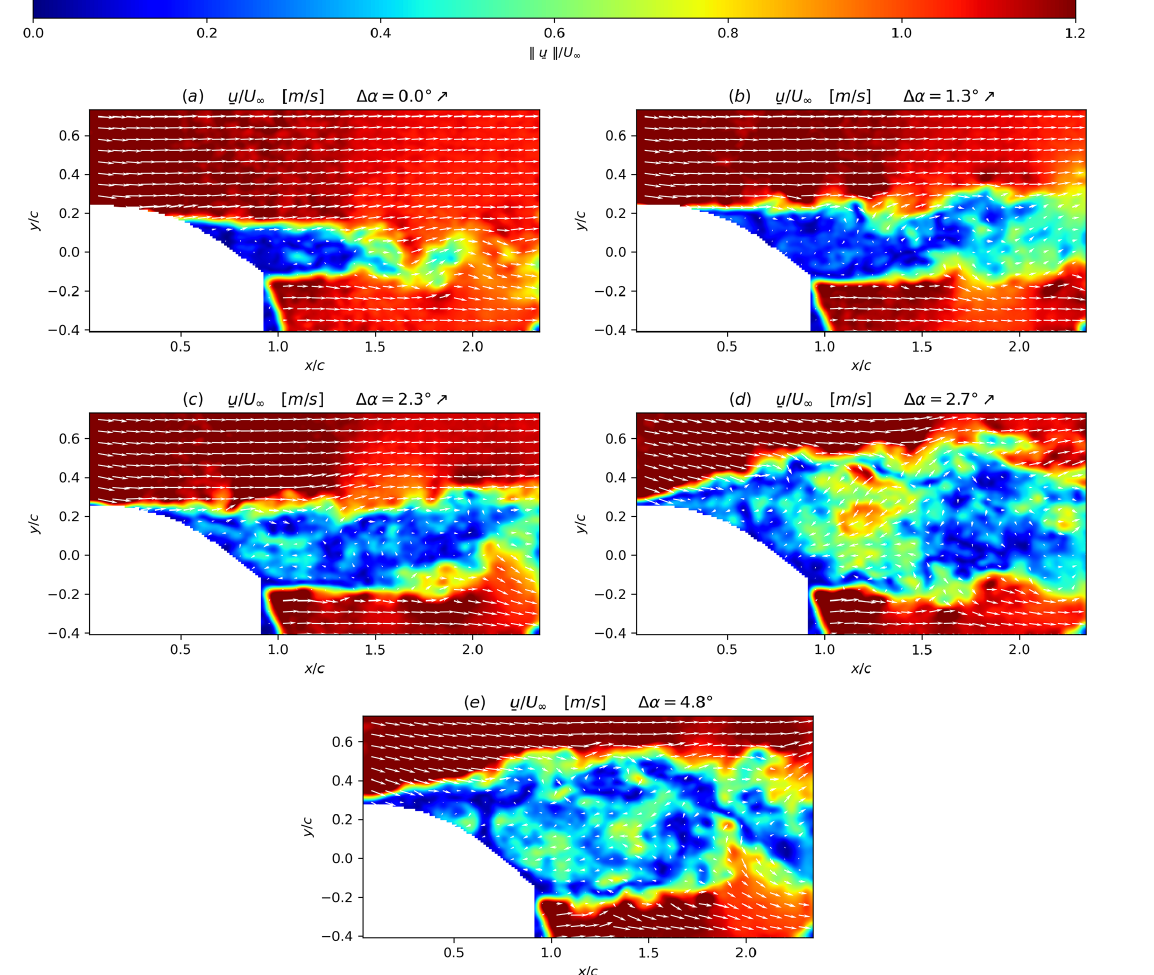
Figure 8. Instantaneous velocity fields superposed with isocontours of the velocity modulus (i.e. (cid:107) u (cid:107) ) at different (cid:49)α values corresponding to points of the blade oscillation given in Fig. 7 during the upstroke phase (noted (cid:37) ): (a) is a point at the lowest (cid:49)α of the upstroke phase of the oscillation cycle, (b) is an intermediate point, (c) is a point just prior to stall, (d) is a point just after the stall and (e) corresponds to a point at the maximum amplitude of the blade oscillation